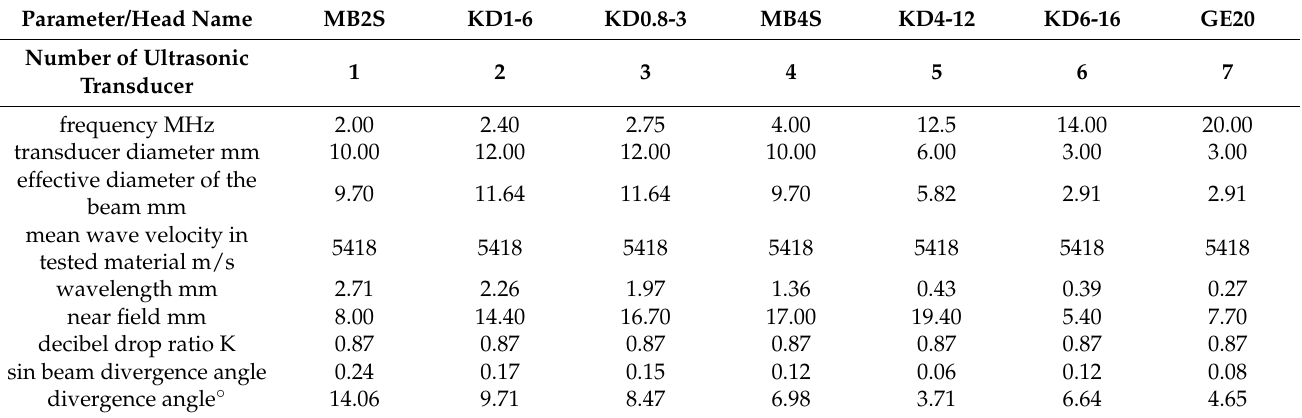
Table 1. Characteristics of the ultrasonic heads used in the study of basic acoustic parameters of Ti6Al4V manufactured in conventional process.